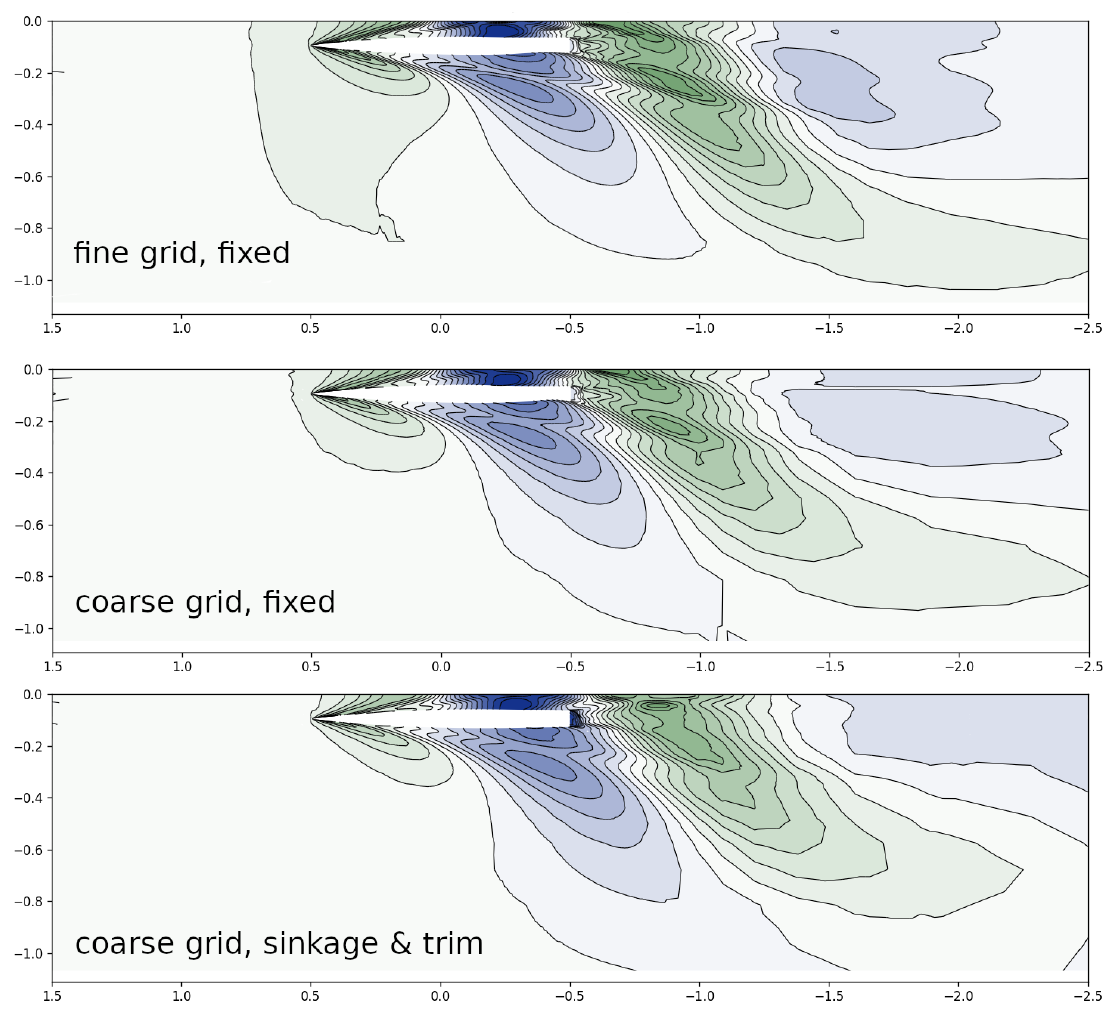
Figure 16. Contour plot of the free surface on the fine and coarse grid without sinkage and trim as well as on the coarse grid with sinkage and